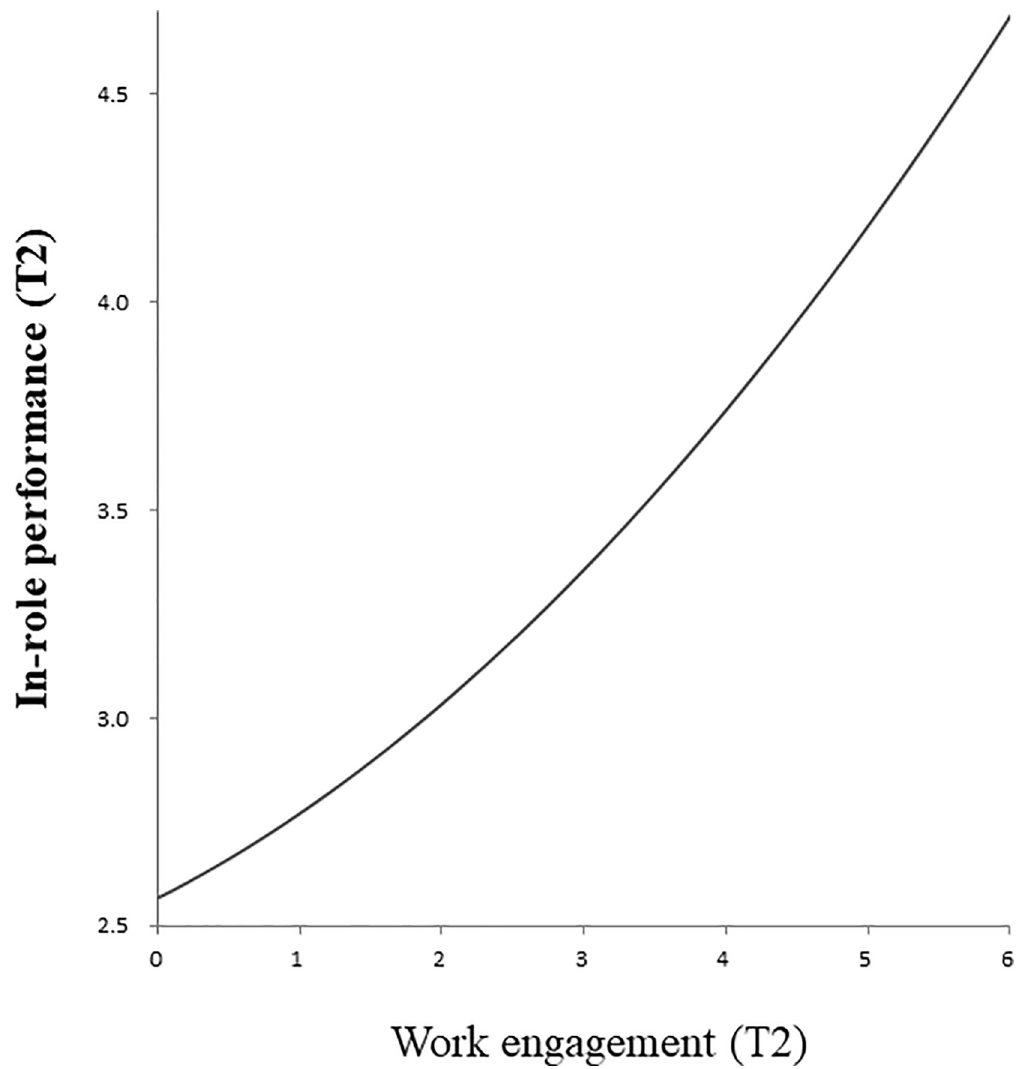
Fig 4. Curvilinear relation between work engagement at Time 2 (T2) and in-role performance at Time 2